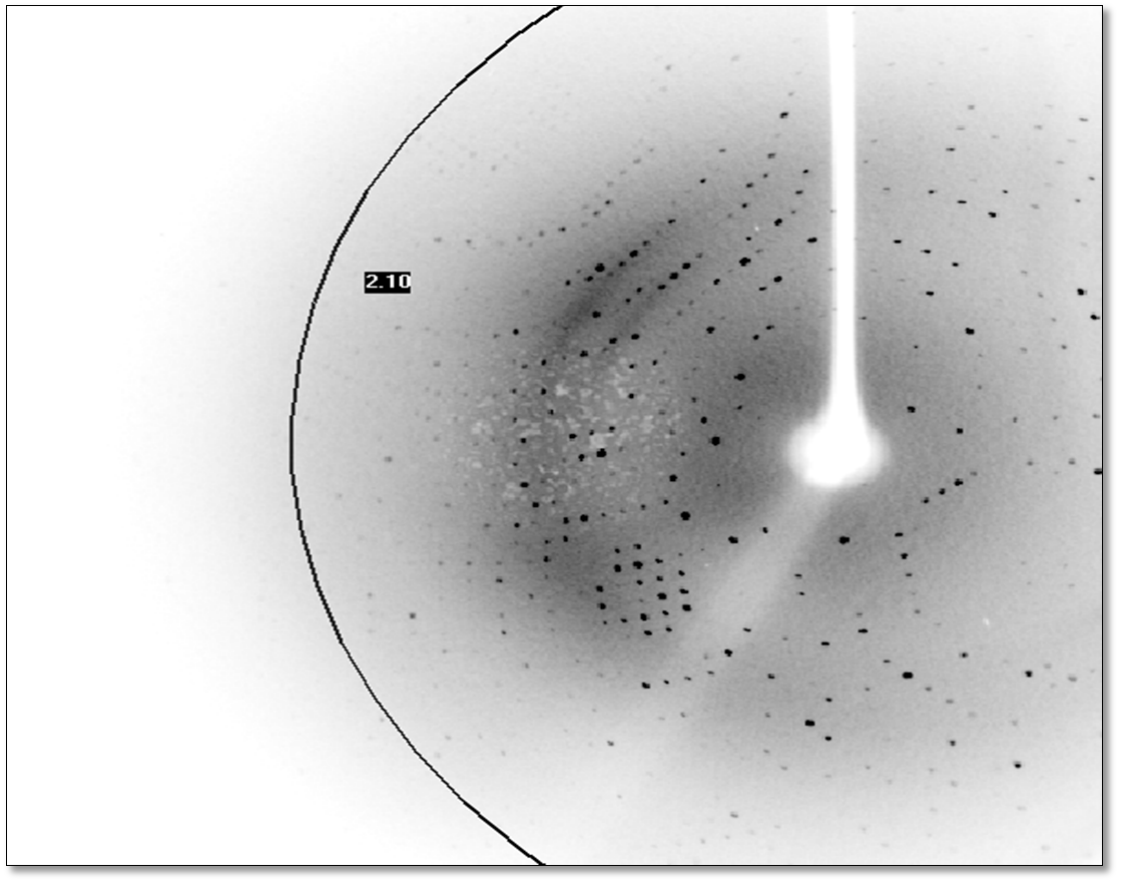
Figure 8. Diffraction patterns of thermostable mutant lipase D311E. The resolution is ~2.1 Å at the edge with starting position; distance: 50.00 mm, 2theta: 22.00°, Omega: 31.64°, Phi: 271.48°, Chi: − 30.01° and ending position; distance: 50.00 mm, 2theta: